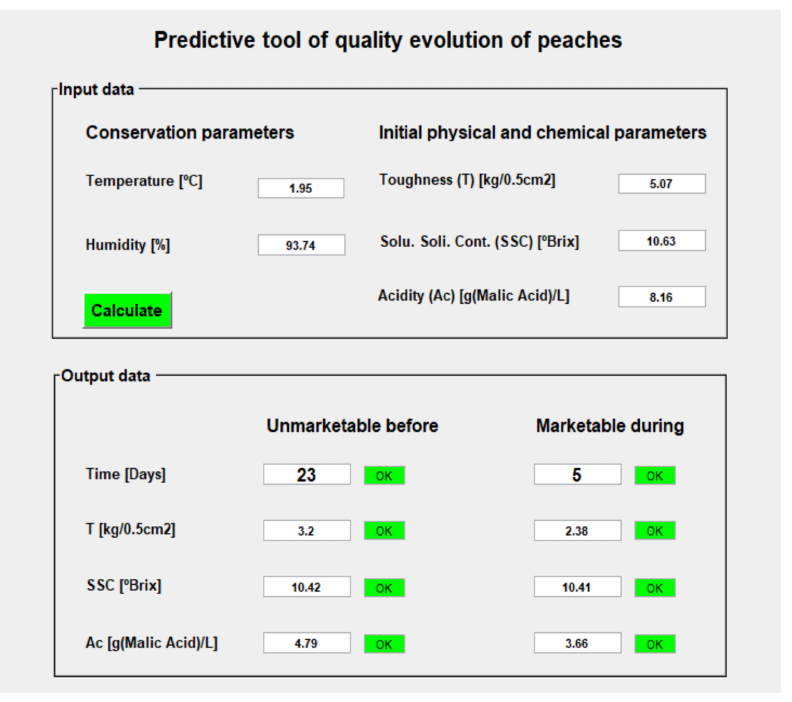
Figure 7. User interface of the decision support system for the storage conditions provided by the cold chamber of farmer